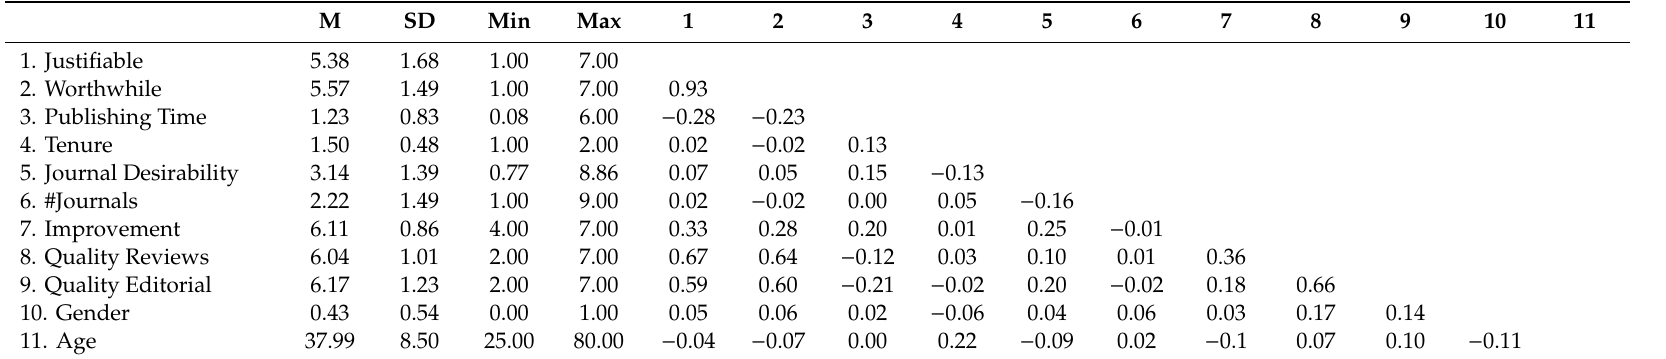
Table 1. Descriptive statistics.